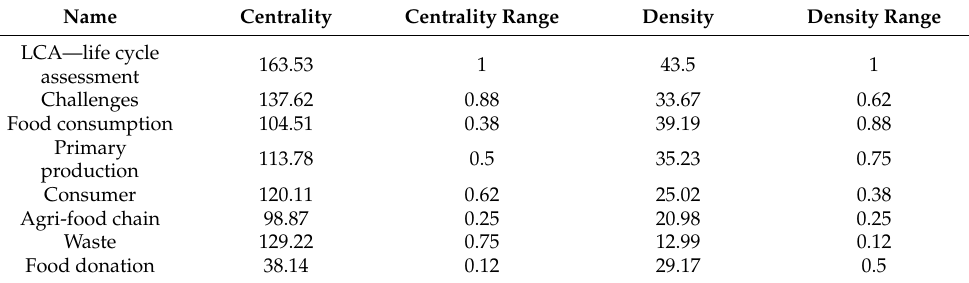
Figure 10. Strategic diagram: ( a ), main thematic network; ( b – d ) 2018–2019 period. Table 4. Cluster